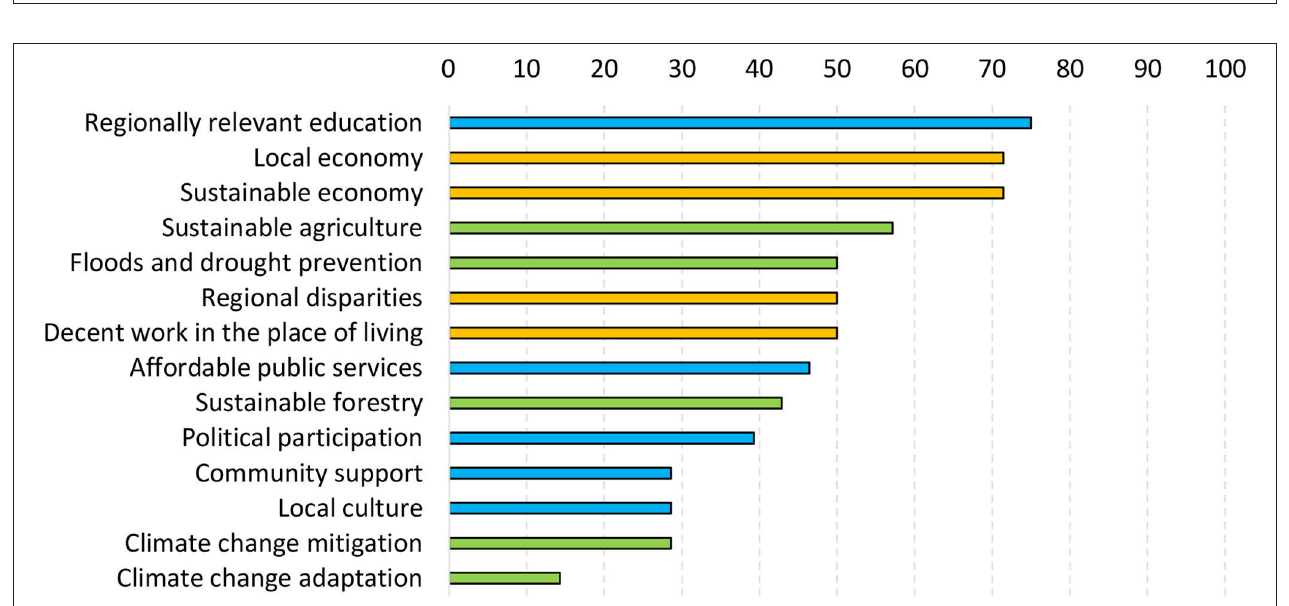
FIGURE 1 | Assessment of strategies and policies as an inspiration for sustainable development on the local level. Answers to the question “Are these strategies and policies useful as an inspiration for planning your LAG’s activities toward sustainable development?” N = 51.